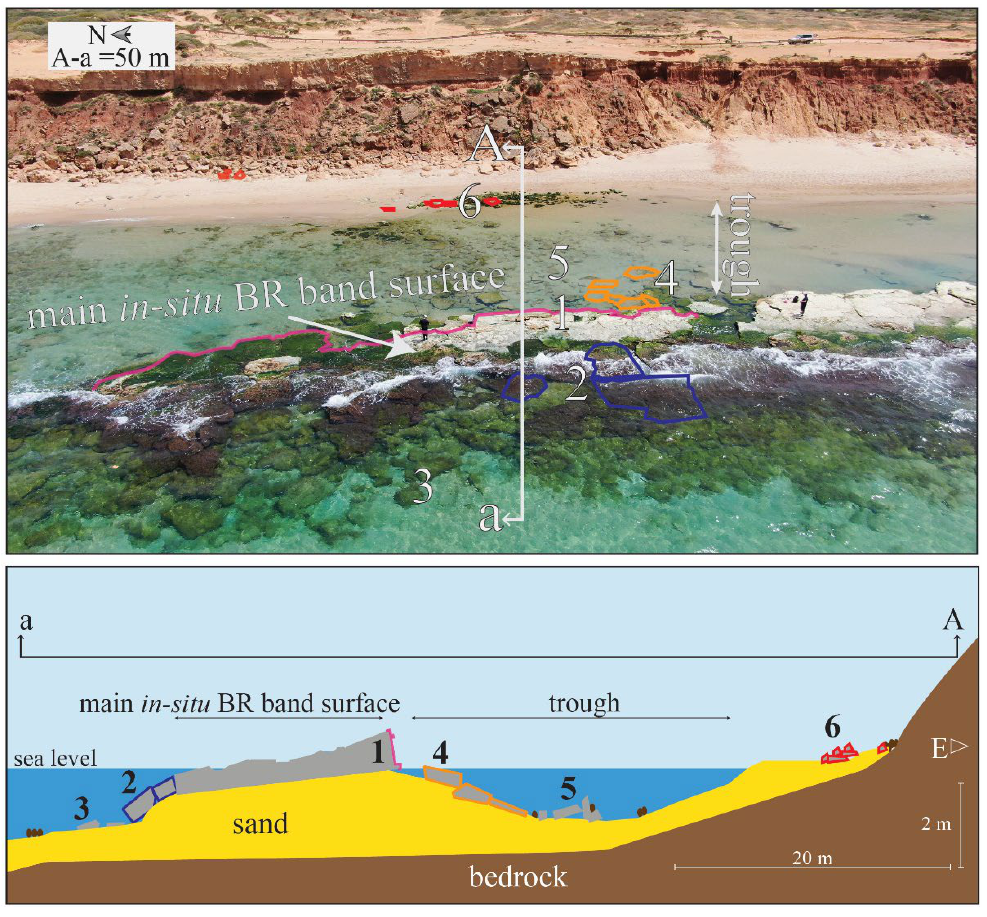
Figure 10. Aerial view (upper) and schematic lateral cross-section (lower) of BR outcrop: showing typical erosion morphological features occurring on intertidal BR outcrops. Numbers represent the morphological features ( 1 : main band of in-situ BR outcrop, 2 : tilted detached BR beds which underwent settling facing the sea side, 3 : detached BR plates which settled near the outcrop sea side front; 4 : detached BR plates which dropped and settled near the outcrop’s land side front, 5 : detached BR plates concentrated inside the trough, 6 : detached BR plates concentrated at backshore).